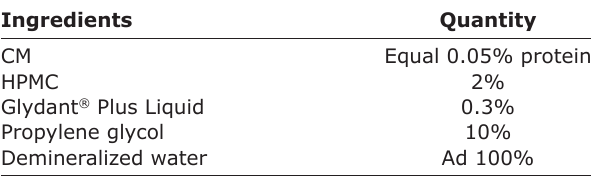
Table-1: Formulation of CM [15,16].